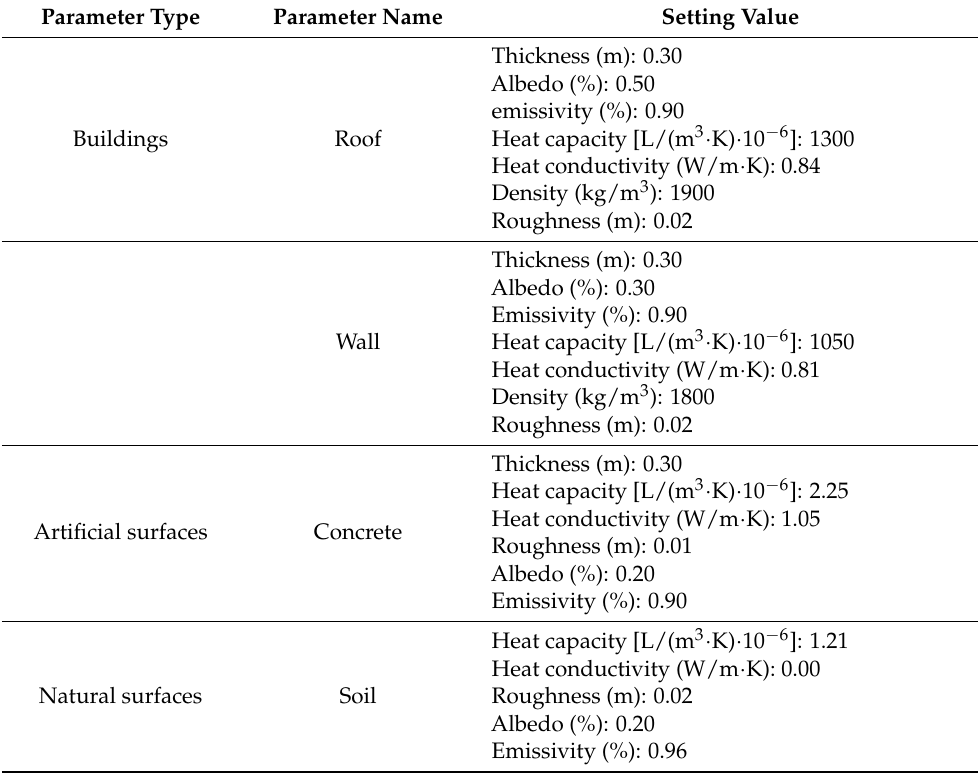
Table 1. Main thermal attributes of buildings and surfaces in ENVI-met